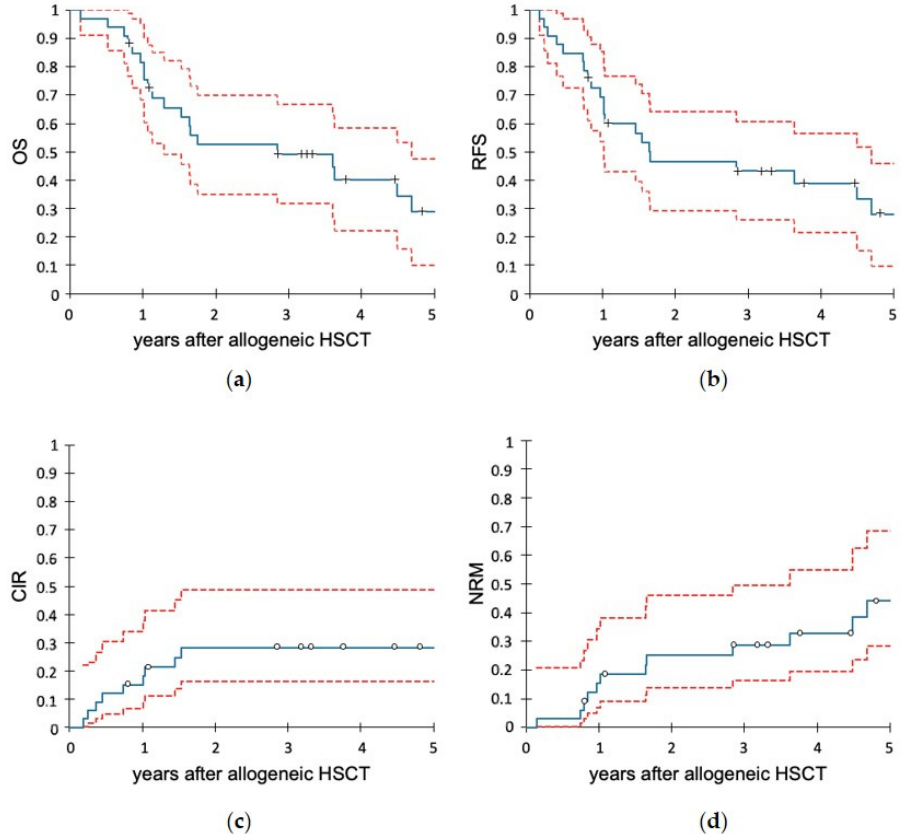
Figure 4. Outcomes of all patients receiving an allogeneic HSCT (33 pts). Follow-up starts with the time of allogeneic HSCT. ( a ) Overall survival (OS). ( b ) Relapse-free survival (RFS). ( c ) Cumulative incidence of relapse (CIR). ( d ) Non-relapse mortality (NRM). In the diagrams, the blue lines show the Kaplan-Meier curves, and the red lines indicate the respective 95% confidence intervals.